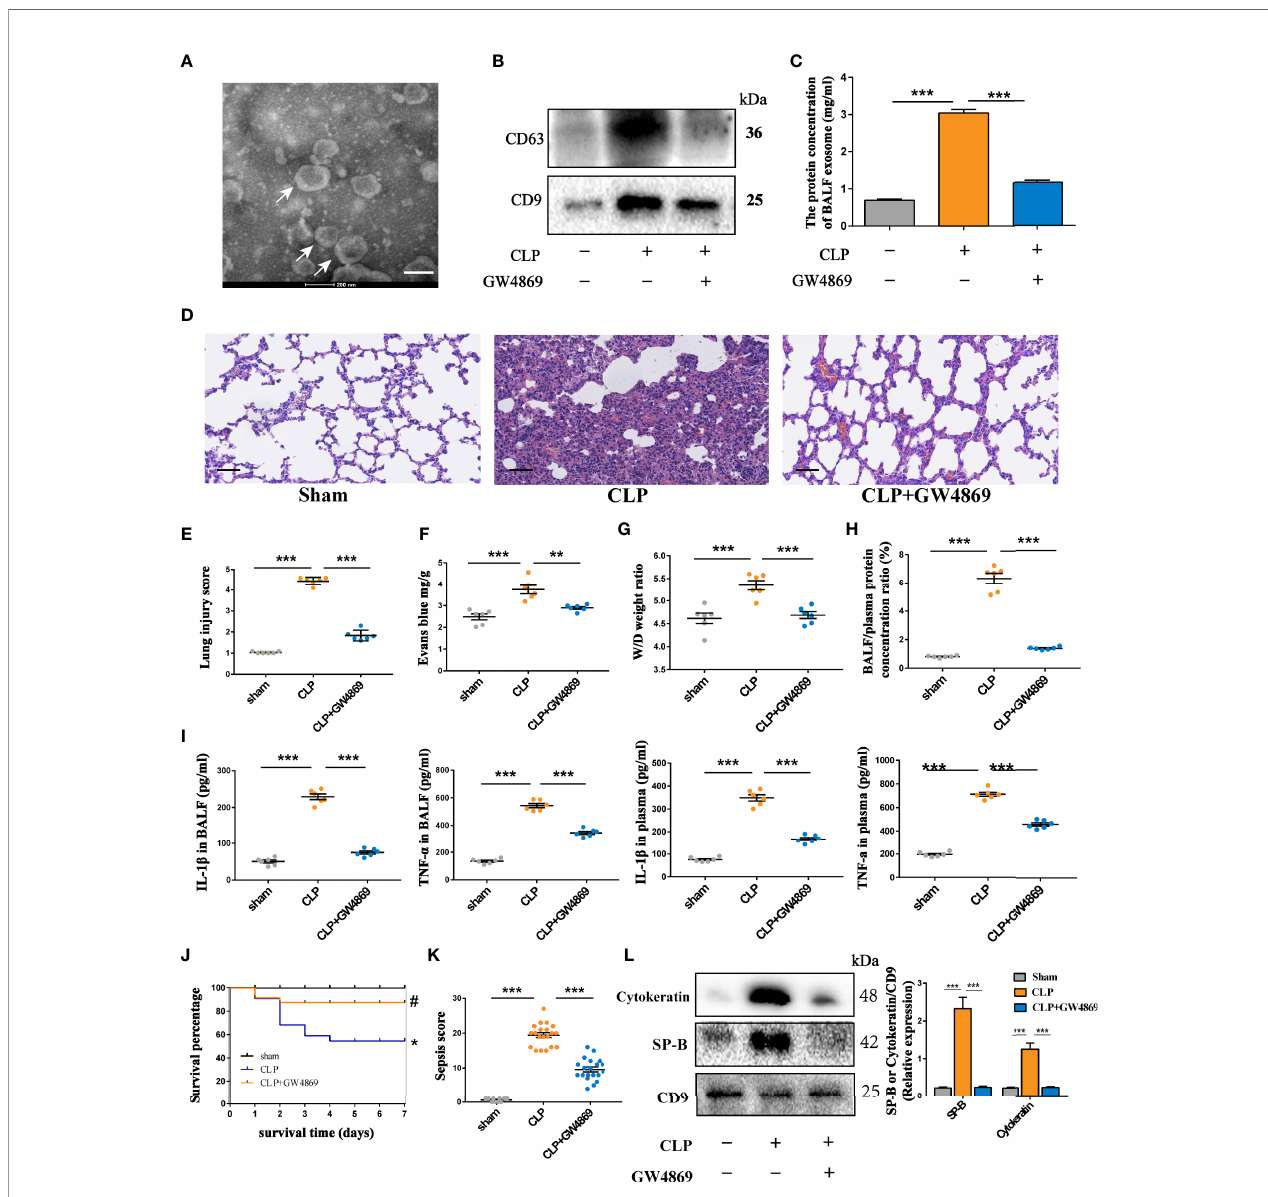
FIGURE 1 | Inhibiting the secretion of intrapulmonary exosomes alleviates septic lung injury. Rats were treated with GW4869 (2.5 m g/g) through airway instillation. CLP procedures were conducted one hour post-treatment, and sham operated rats were used as negative controls. (A) Representative electron micrograph of exosomes puri fi ed from the BALF (indicated by white arrows). Scale bars, 200 nm. (B) Western blot assessment of exosomes showing the presence of CD63 and CD9 in BALF-derived exosomes. (C) Quanti fi cation of exosomal protein concentration in the BALF of each group of rats. (D) Histopathological examination of lung tissue by HE staining, Scale bars,50 µm. (E) Scoring the pathology of lung tissue damage using the Smith scoring method. (F – H) Changes in lung tissue oedema of rats under different treatments. (F) Evans blue content in lung tissue. (G) The wet/dry weight ratio in lung tissue. (H) The ratio of protein concentration in BALF to plasma. (I) The expression levels of IL-1 b and TNF- a in BALF and plasma. (J, K) Survival rate of rats in each group within 7 days and the changes in sepsis score of each group. The Kaplan-Meier method combined with the log-rank test was used to compare multiple populations. Compared with the sham group, *P<0.05; compared with the CLP group, # P<0.05; n=10 for the sham group, n=20 for the other groups. (L) Western blot assessment of the expression of epithelial cell- speci fi c marker proteins SP-B and cytokeratin in exosomes derived from BALF and quantitative analysis of the protein grey value. Data are presented as the mean ± S.E.M. **P<0.001, ***P<0.001 compared between two groups. n=6 per